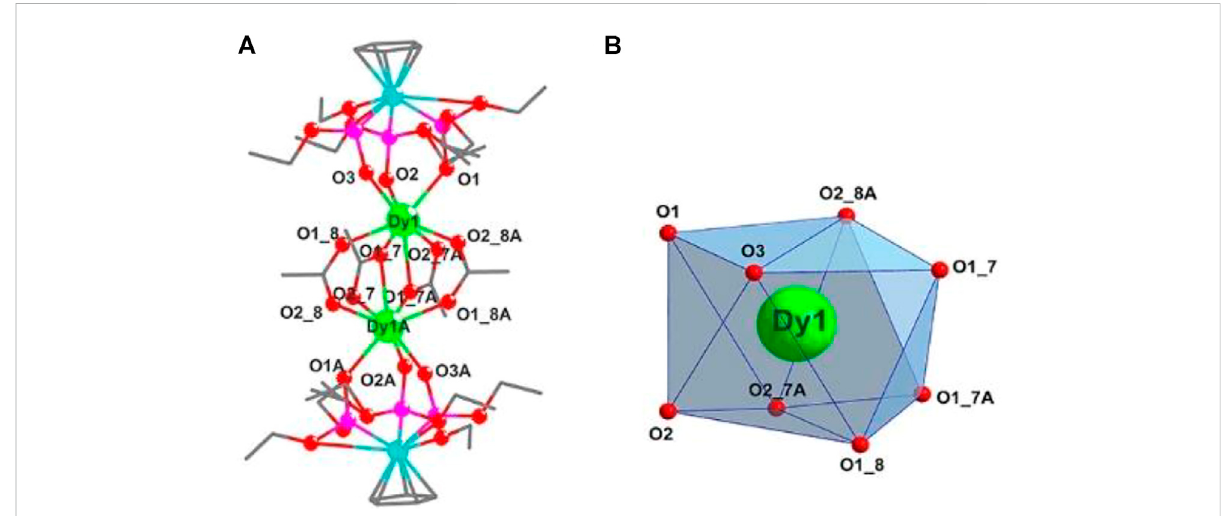
FIGURE 2 (A) Molecular structure diagram of 1 (Dy, green; Co, aqua; O, red; P, pink; and C, gray). The H atoms are omitted for clarity. (B) Coordination polyhedron of the Dy1 3+